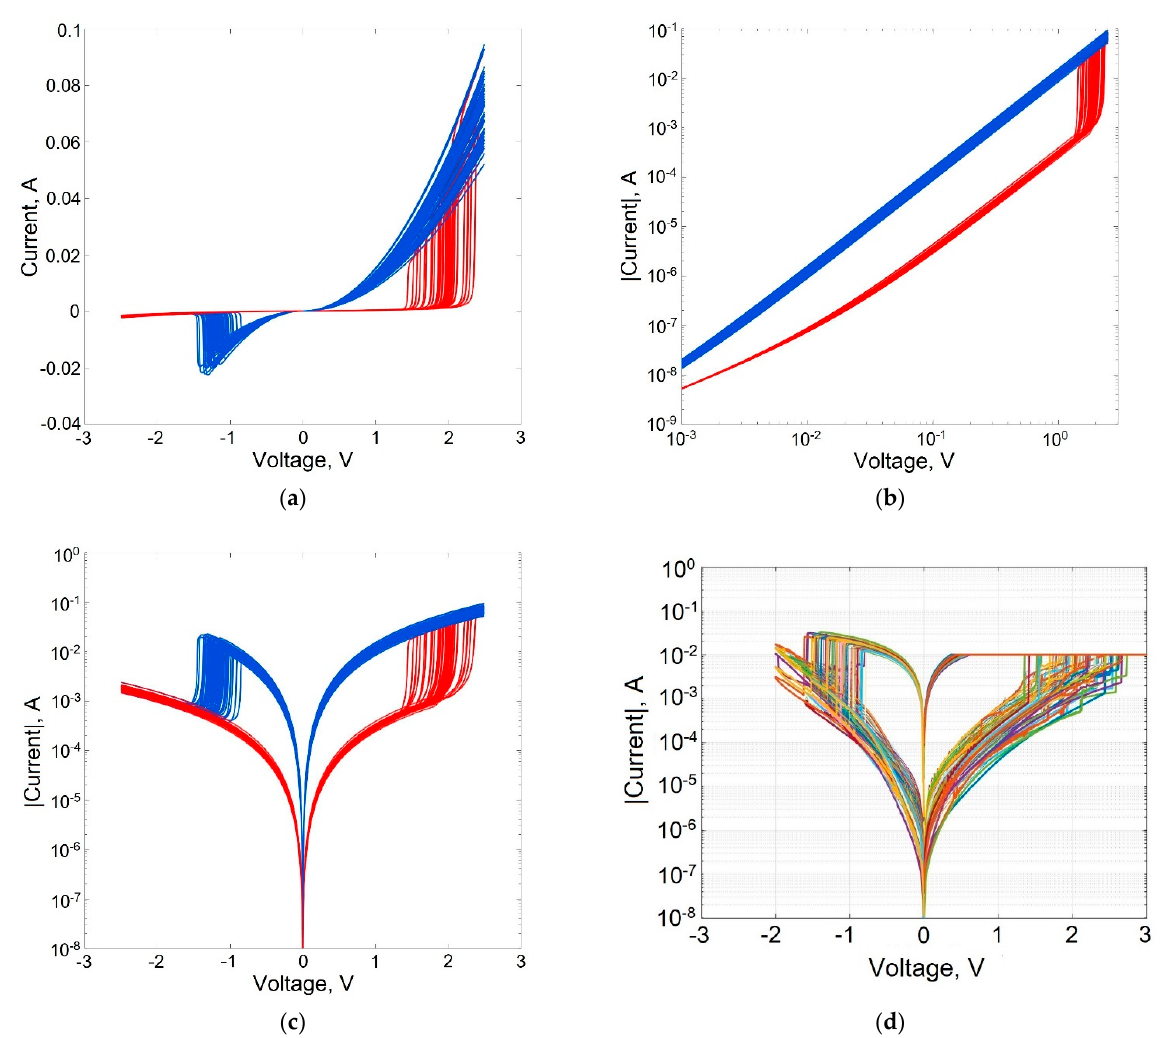
Figure 4. I–V characteristics of a memristive element, taking into account the statistical spread of parameters at D P = 0.1 in linear ( a ), logarithmic ( b ), and semilogarithmic scales ( c, d ): simulation results ( c ) and measurement results ( d ) for memristive structure shown in Figure 2a (measurements were carried out for 35 samples of the memristor structure).